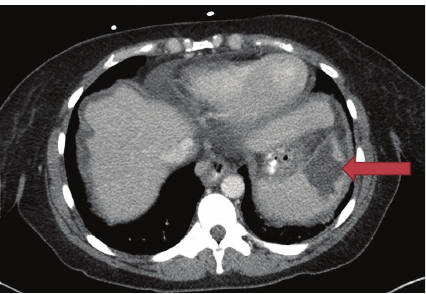
Figure 1: Axial CT scan showing a wedge shaped low-attenuation area in the spleen representing an area of infarction (red arrow).